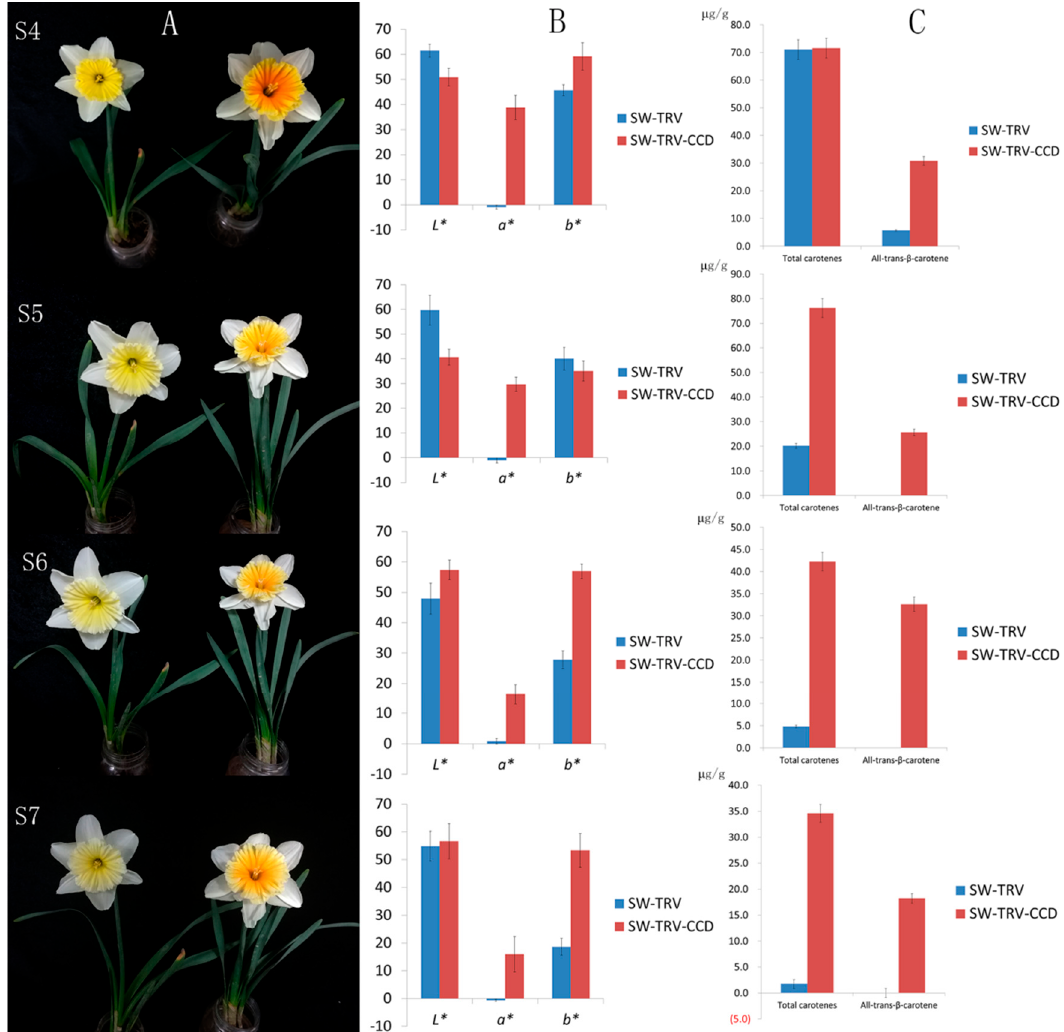
Figure 8. The phenotype and carotenoid contents of NtCCD4-silenced coronas during S4-S7 of SW. a, the phenotype of the tobacco rattle virus (TRV) control (left) and NtCCD4 silenced (right) plants. ( A ): Coronas of NtCCD4 silenced plants changed to be orange red, while the TRV controlled plants did not showed any difference from the wild type SW. ( B ): the chromaticity parameters L *, a * and b * of the coronas of TRV control and NtCCD4 silenced plants measured by CIE 1976 L * a * b *. In the CIE 1976 L * a * b * system, the L * value represents lightness of shade ranging from 0 (black) to 100 (white), the color parameter a * positive are for red and negative are for green, and color parameters b * positive are for yellow and negative are for blue. The higher a* value are, the color closer to red. ( C ): the total carotenoid content and all-trans- β -carotene content in coronas SW-TRV and SW-TRV-CCD ( μ g/g).